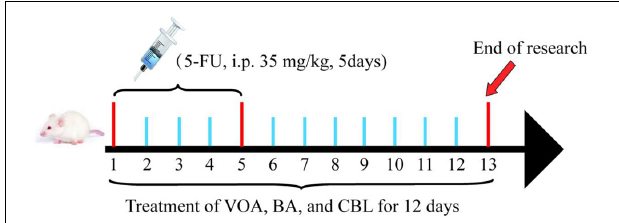
FIGURE 2 | Treatment schedule. All of the rats, except for the normal controls, received 5-FU (35 mg/kg daily, i.p.) for 5 days. Then, 4 h before chemotherapy, rats received CBL, VOA, or BA treatments (via gavage) once daily for 12